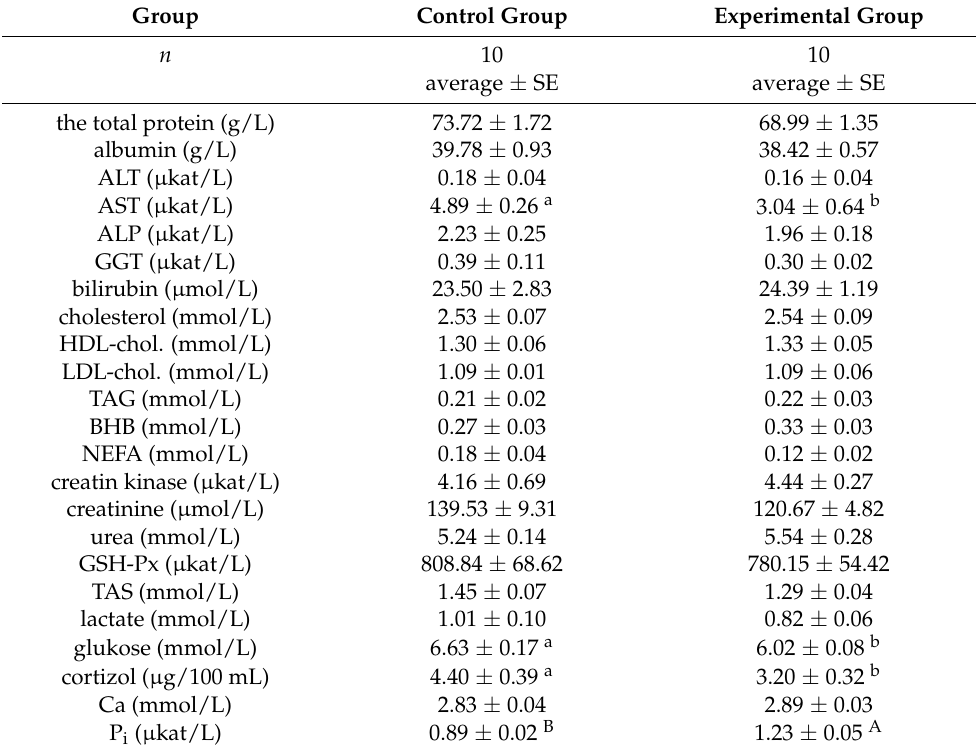
Table 6. Blood sample four: up to 60 min after the end of physical exercise on day 56.